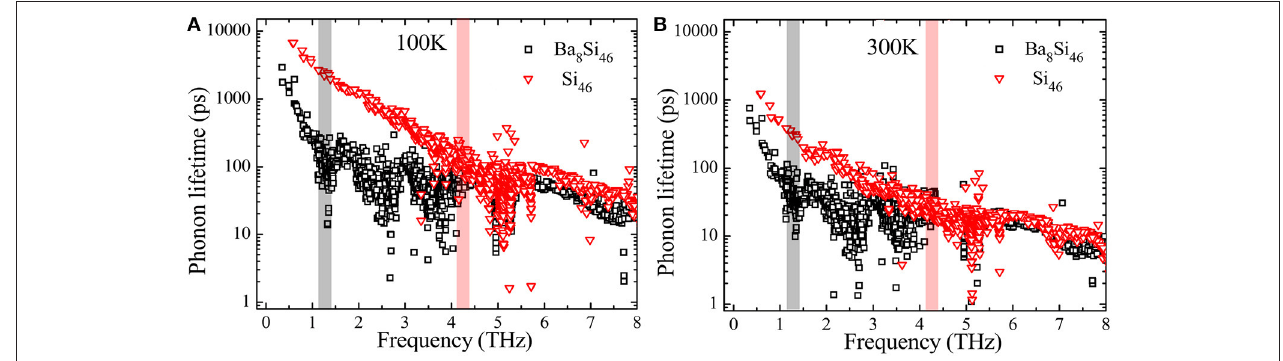
FIGURE 5 | Phonon lifetime for Ba 8 Si 46 and Si 46 at 100K (A) and 300K (B) , respectively. The shadowed regions highlight the upper bound of acoustic branches for Ba 8 Si 46 (black) and Si 46 (red), respectively.